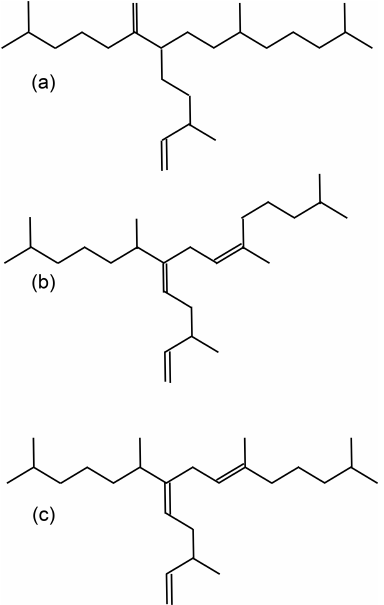
Figure 1. The molecular structures of (a) IPSO 25 , (b) the HBI Z- triene and (c) the HBI